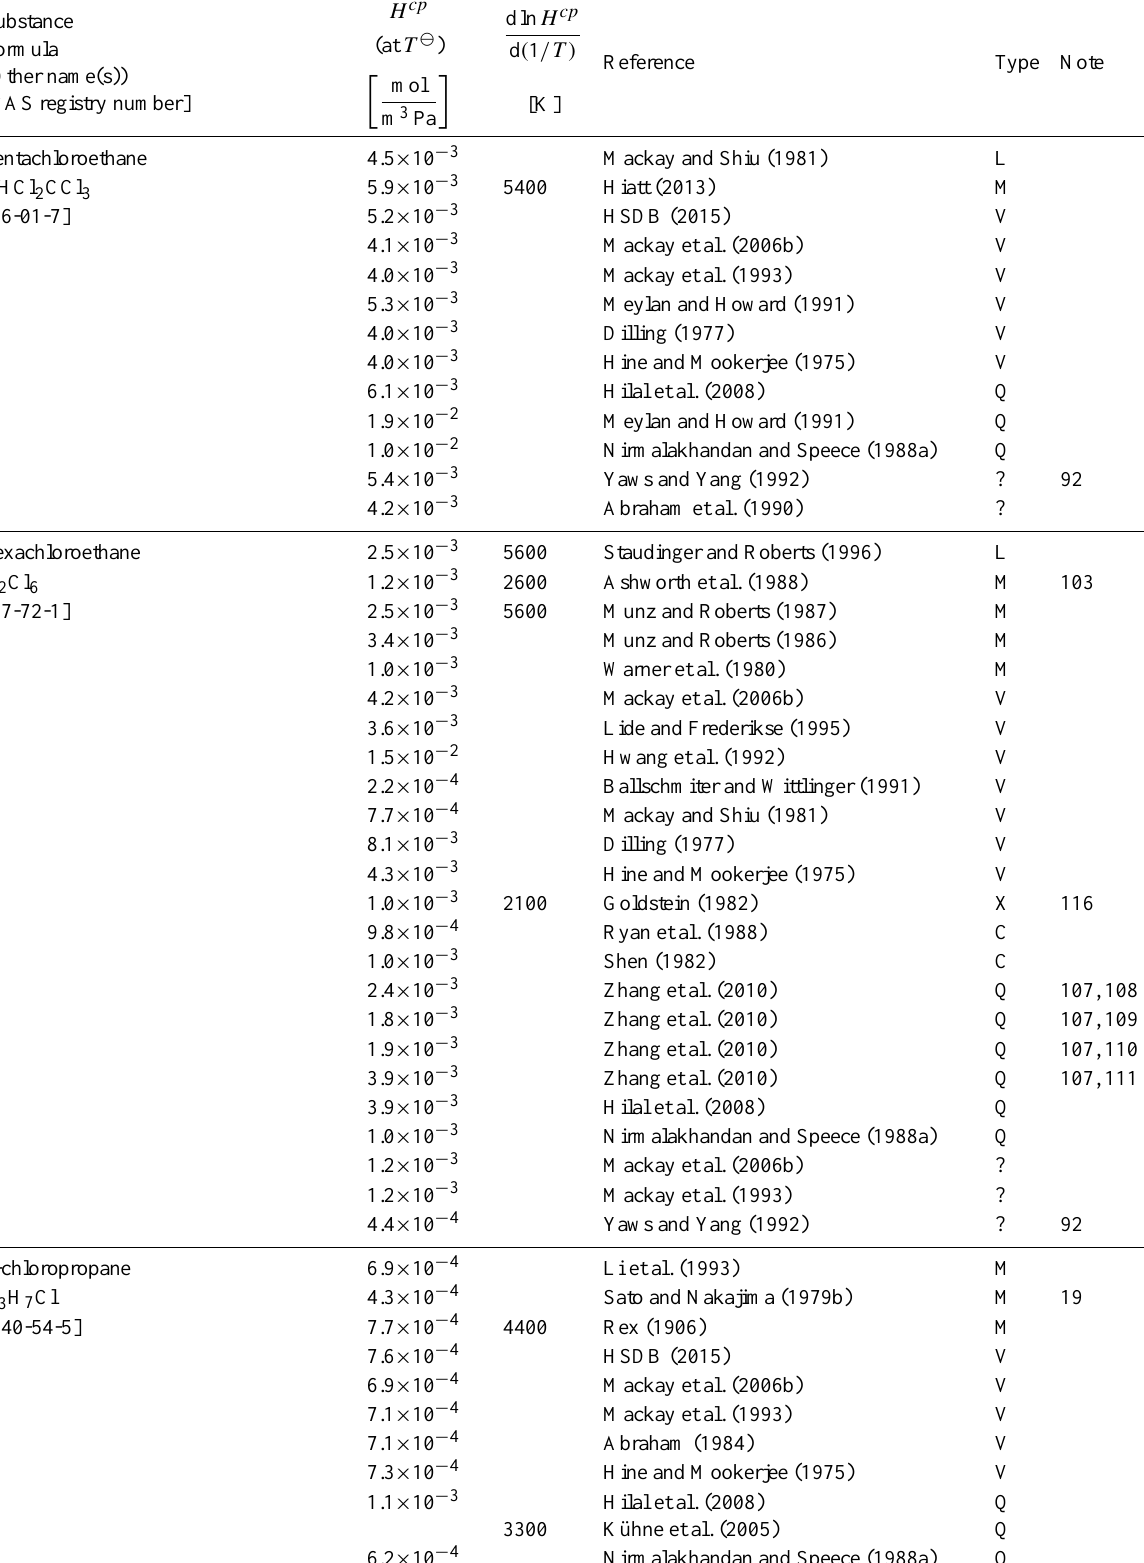
Table 6: Henry’s law constants for water as solvent